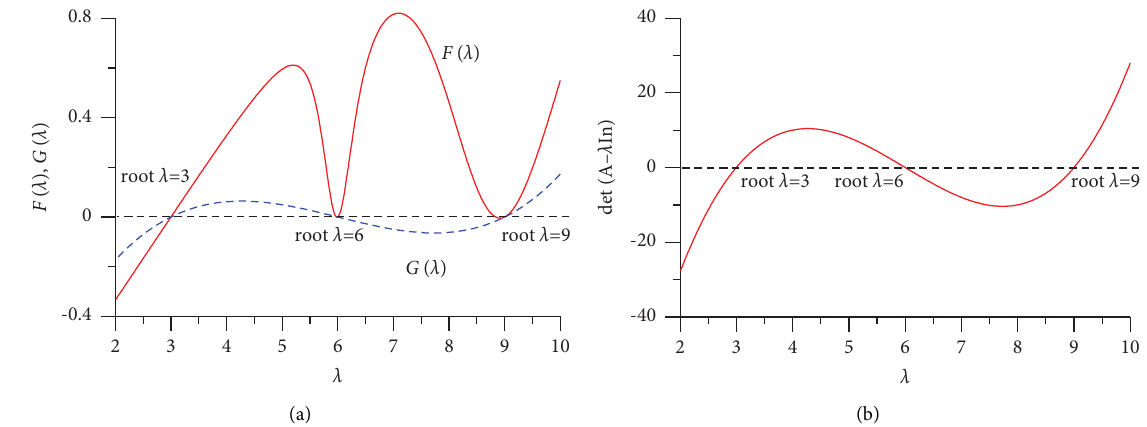
Figure 1: For Example 1, showing three roots of the nonlinear equations obtained from (a) the Rayleigh quotient and new quotient, and (b) characteristic equation corresponding to eigenvalues 3, 6, and